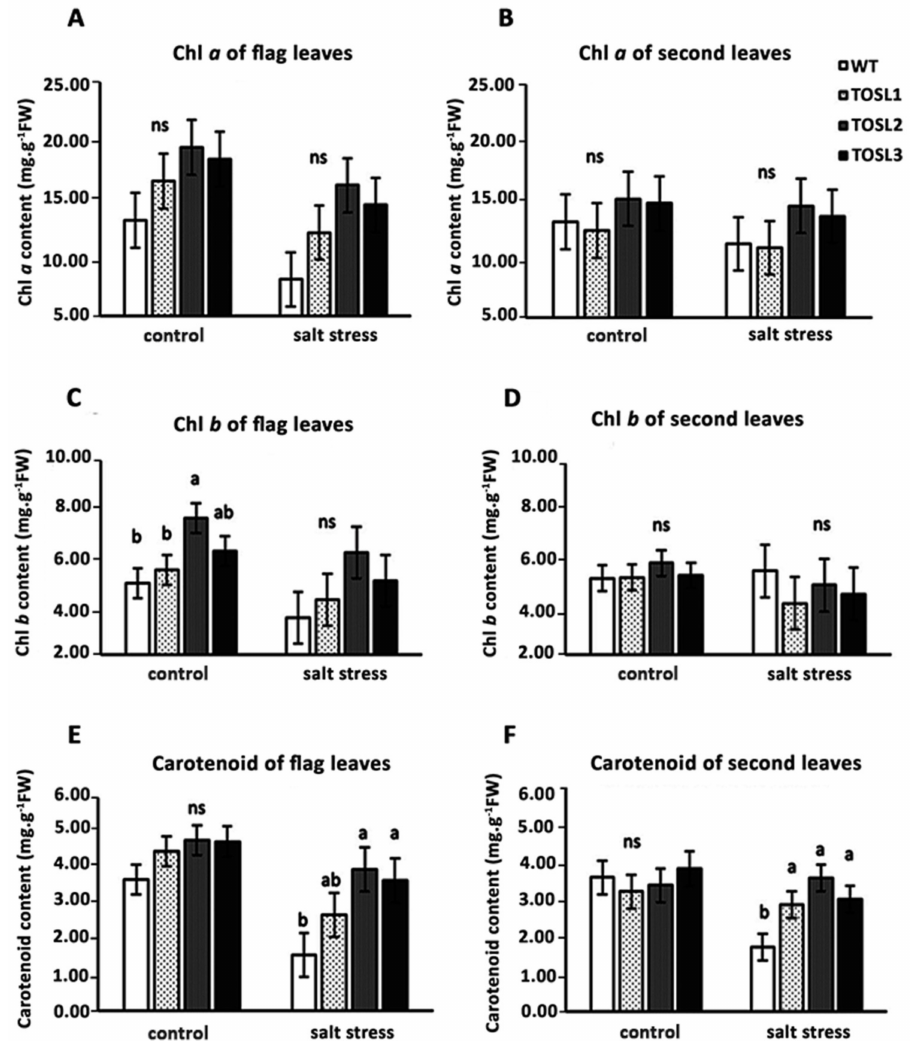
Figure 6. Photosynthetic pigments in flag leaves ( A , C , E ) and second leaves ( B , D , F ) 9 days after the salt-stress treatment at the booting stage. The data were presented as the mean ± SE and a different letter above the bar showed the significant difference in means ( p < 0.05) based on Tukey’s range test analysis. ns represents no statistically significant difference among